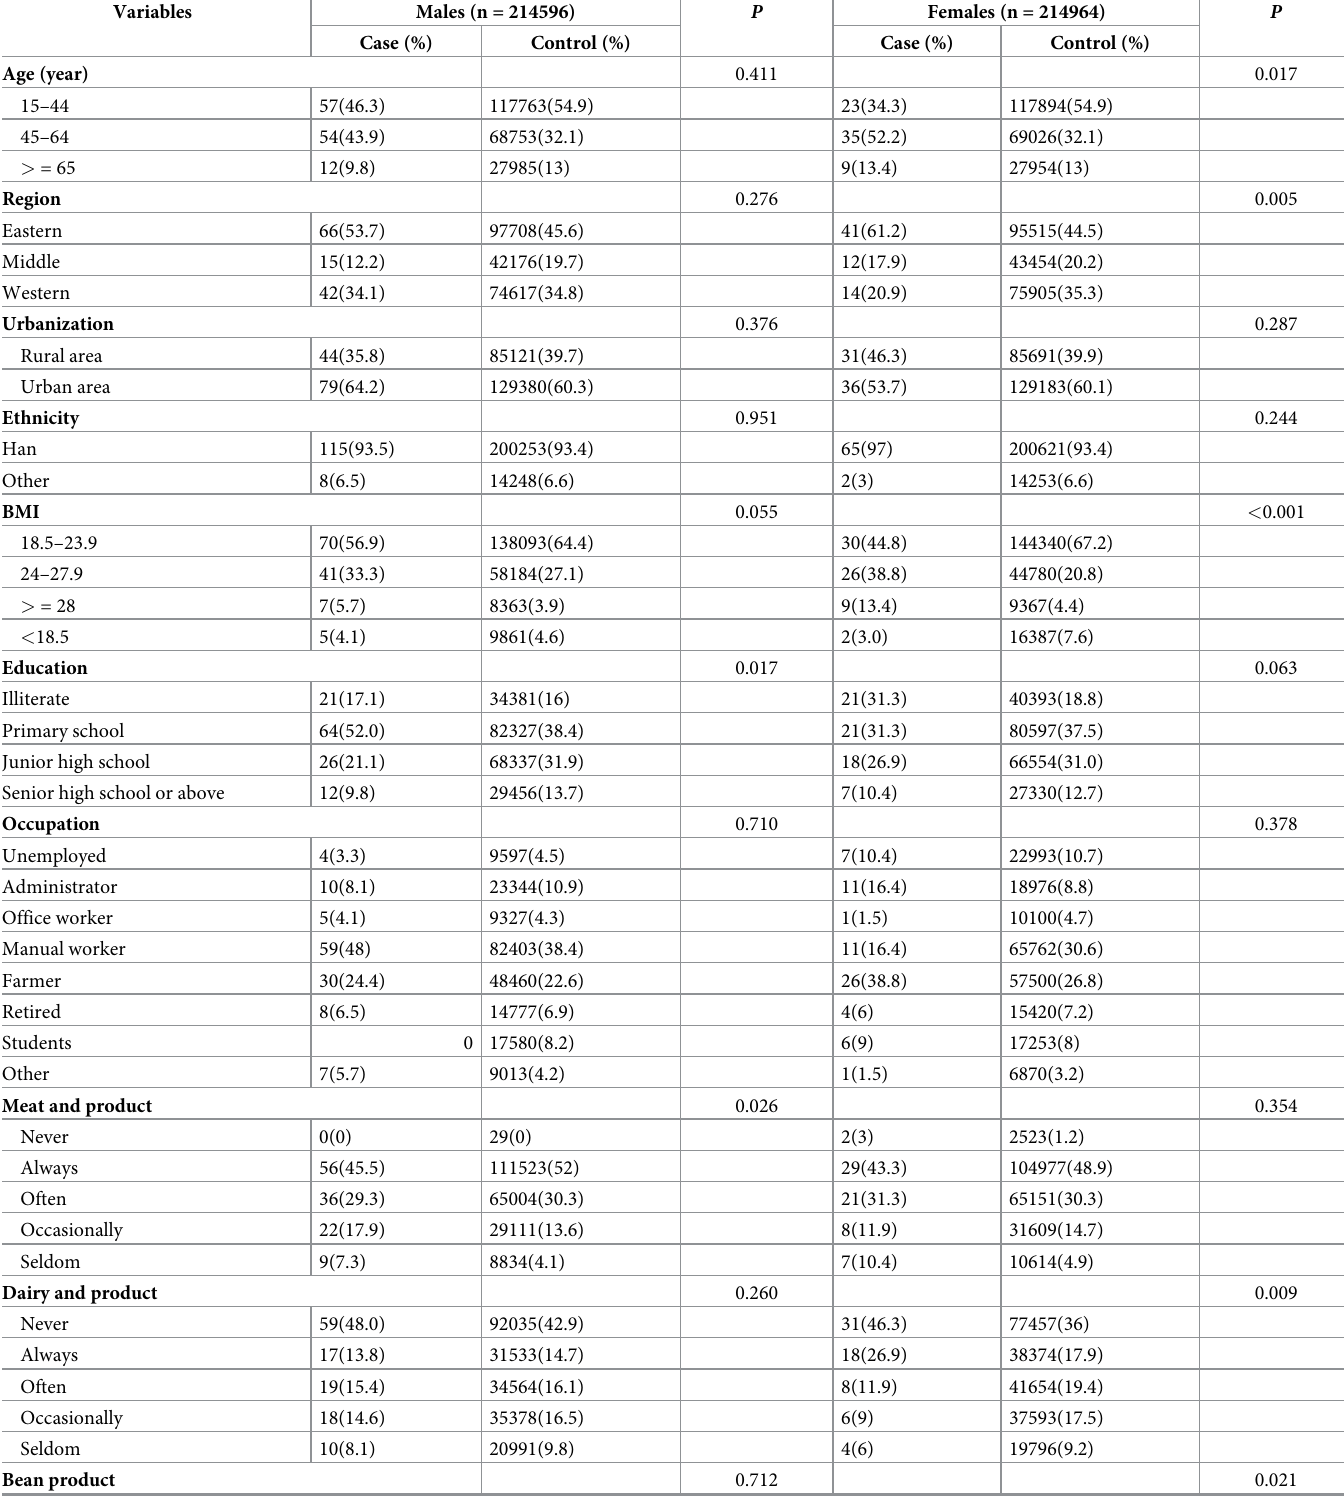
Table 4. Detailed results of univariate analysis for variables of